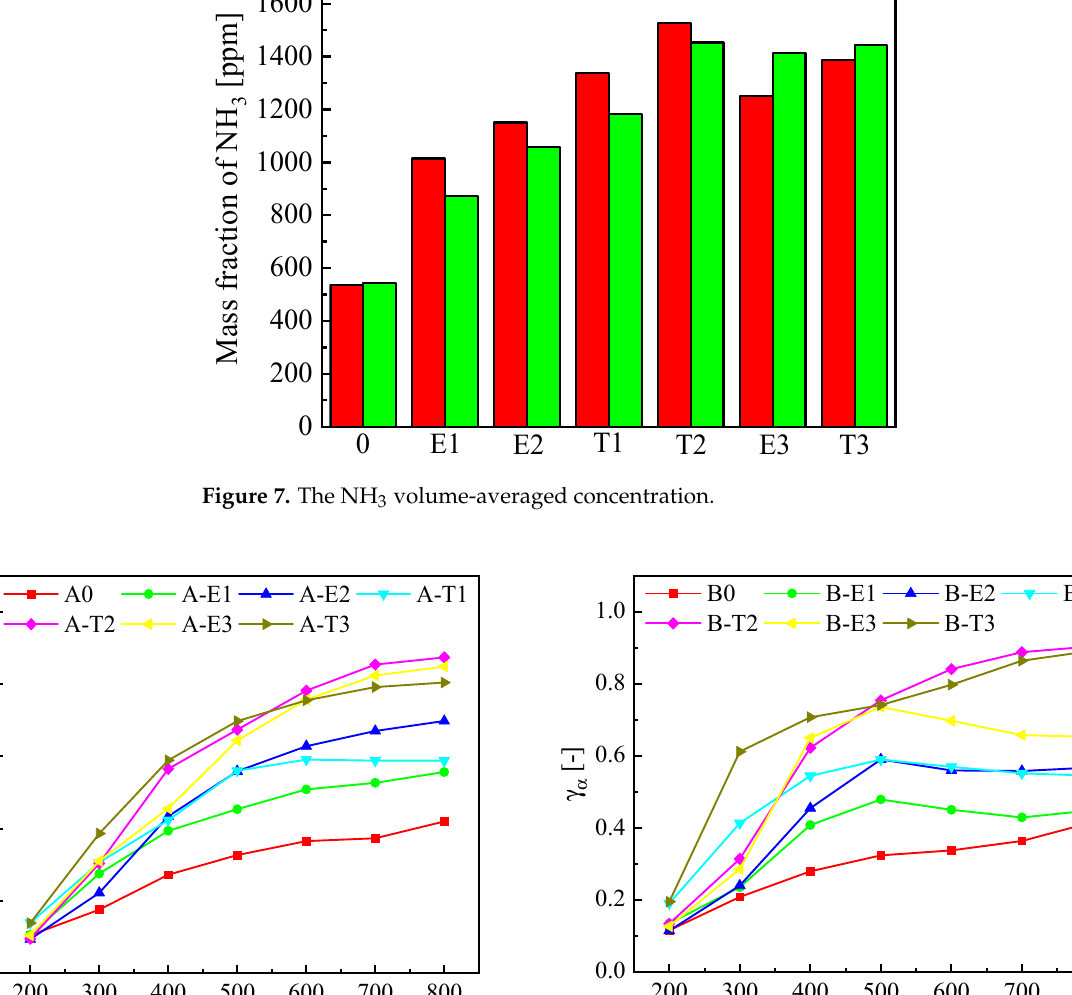
Figure 6. The NH 3 concentration.